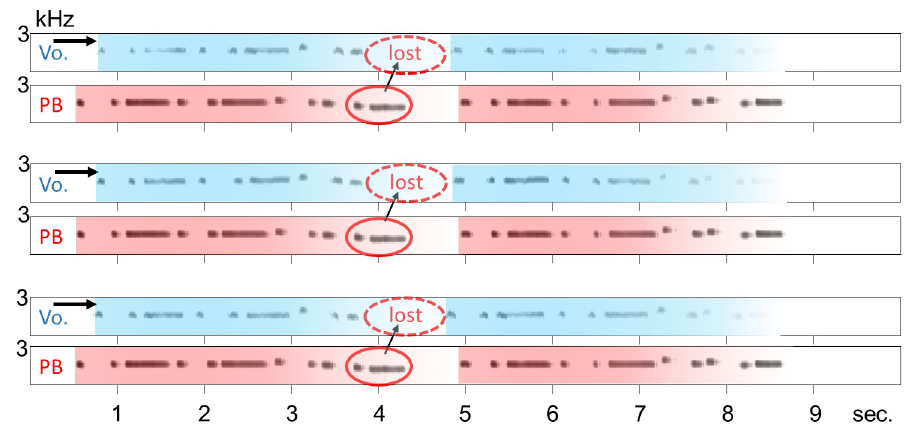
Fig 3. Examples of irregular vocal sequences with playback of the melody. These recordings were obtained from bird PY (the same recordings are shown as PY#15, PY#16 and PY#17 in S1 File ). The vocalizations began following the playback (indicated by black arrows) and the last two notes of the first half were dropped (indicated by red circles).